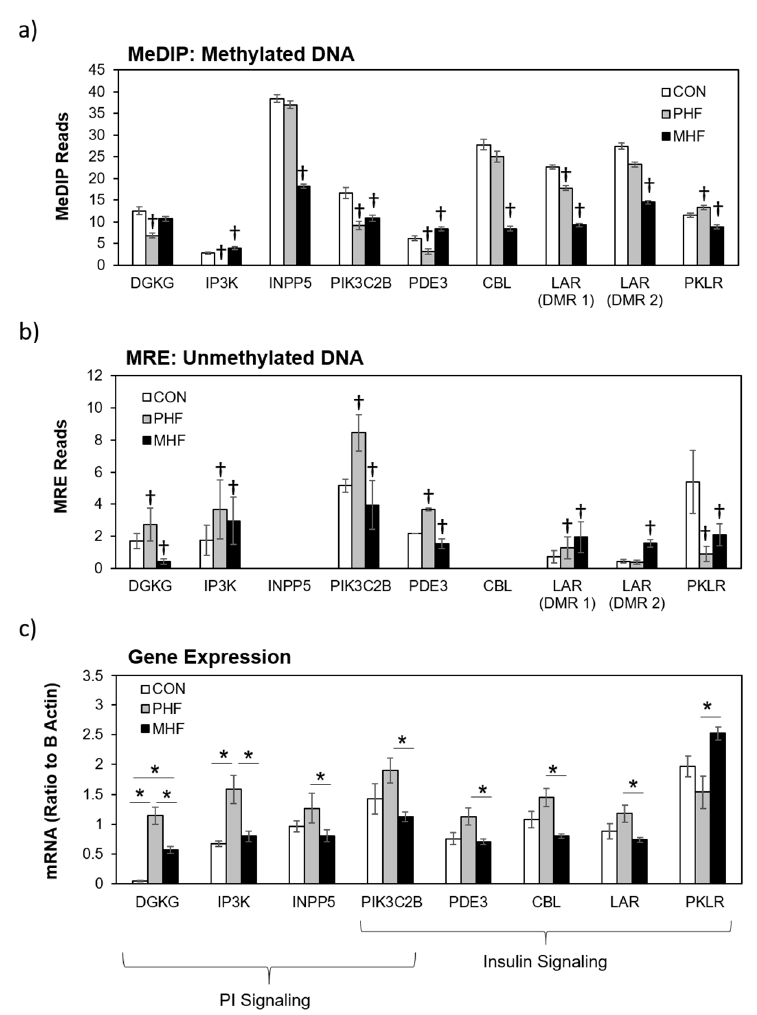
Figure 5. Di ff erential gene expression in the insulin and PI signaling pathways. ( a ) Methylated DNA reads were measured using MeDIP-seq. † denotes a ≥ 15% di ff erence between CON and either PHF or MHF. Data are presented as mean ± SEM across each DMR. ( b ) Unmethylated DNA was measured using MRE-seq. † denotes a ≥ 15% di ff erence between CON and either PHF or MHF. Data are presented as mean ± SEM across each DMR. ( c ) Eight DMGs were significantly di ff erentially expressed between MHF and PHF groups. The bar graph represents the mRNA quantity relative to B Actin. Data are presented as mean ± SEM. * p < 0.05.